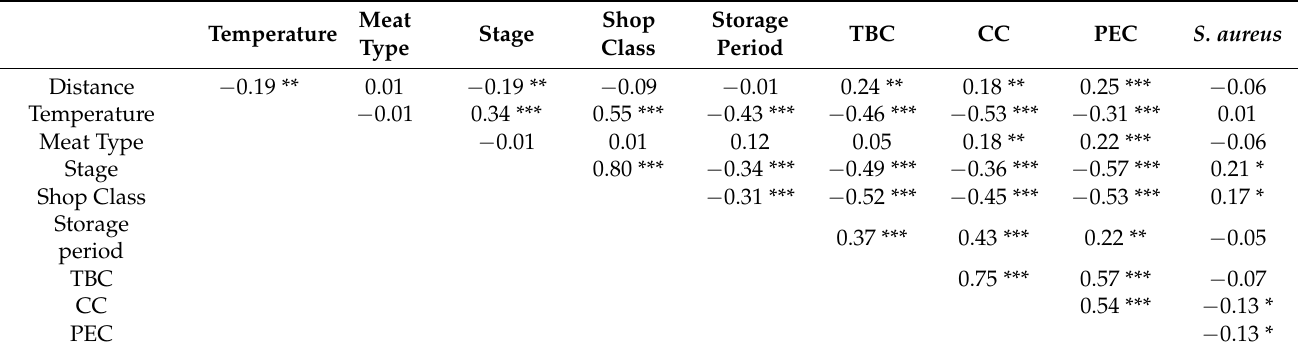
Table 3. Pearson correlation analysis between factors affecting bacterial load on meat and microbial